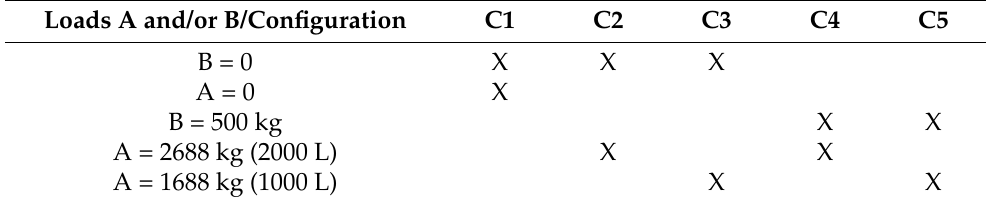
Table 2. Various configurations of additional loads. A—weight of water tank within RAW point, B—additional load in front mount point FAW (as shown in Figure 2), X—applied